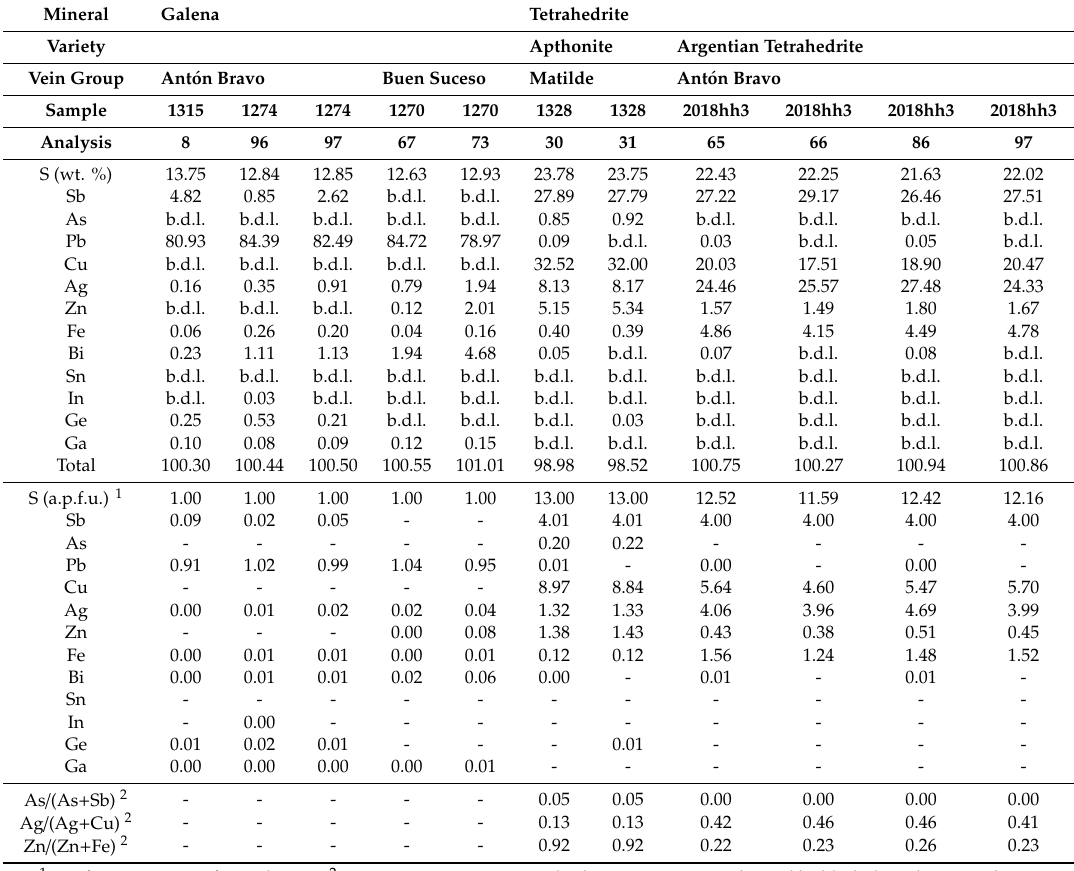
Figure 11. Correlation between elements in stannite from the Huari Huari district.